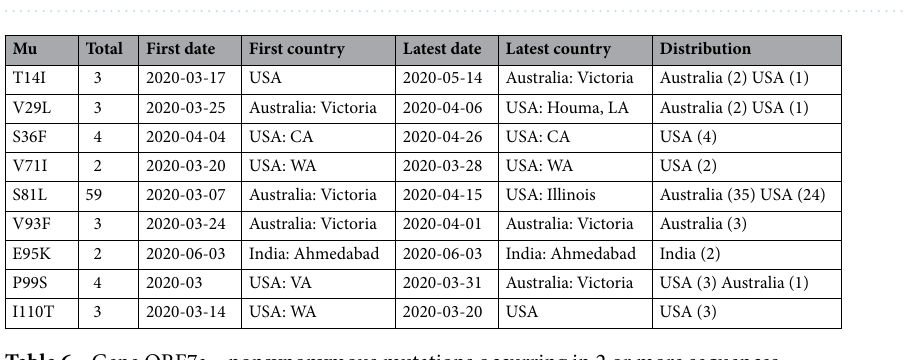
Table 6. Gene ORF7a—nonsynonymous mutations occurring in 2 or more sequences.